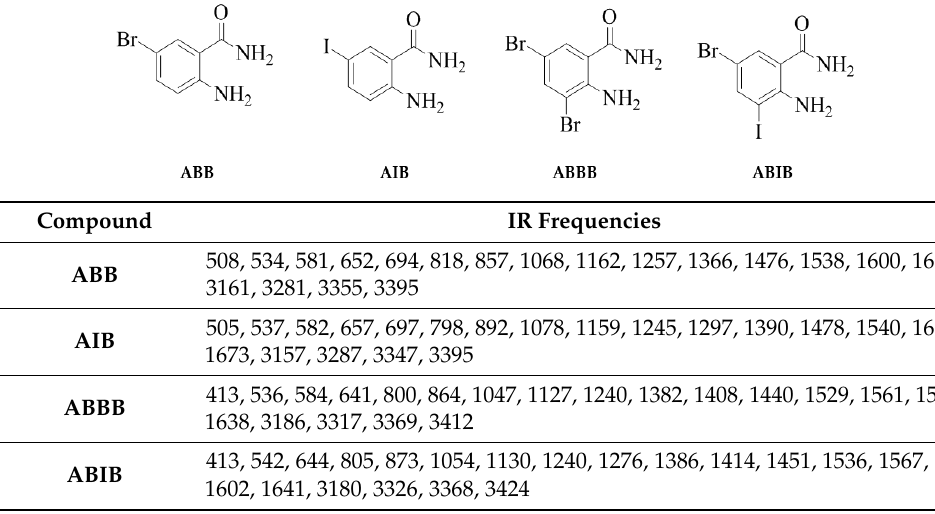
Table 4. The experimental IR frequencies for compounds ABB , AIB , ABBB , and ABIB .